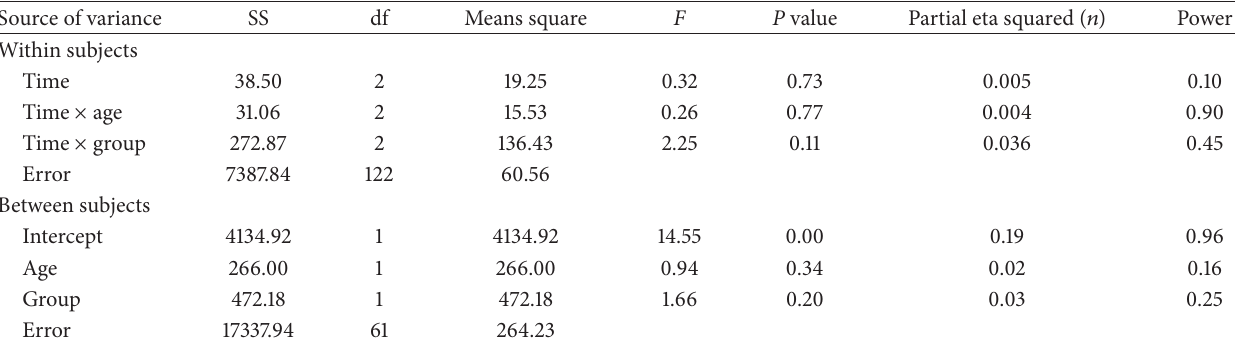
Table 3: ANCOVA results of PedsQL total